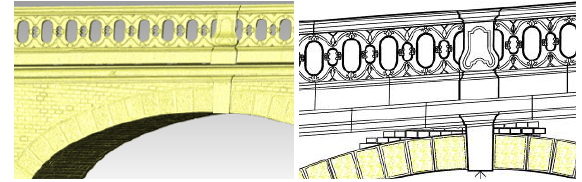
Figure 12. Registered pointclouds of the bridge